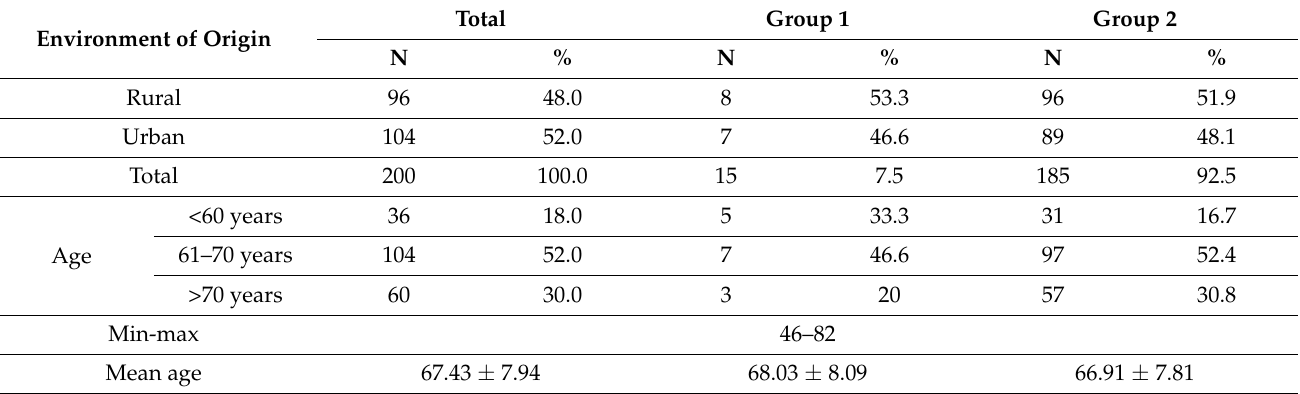
Table 1. Distribution of cases according to the environment of origin, and cases according to age.